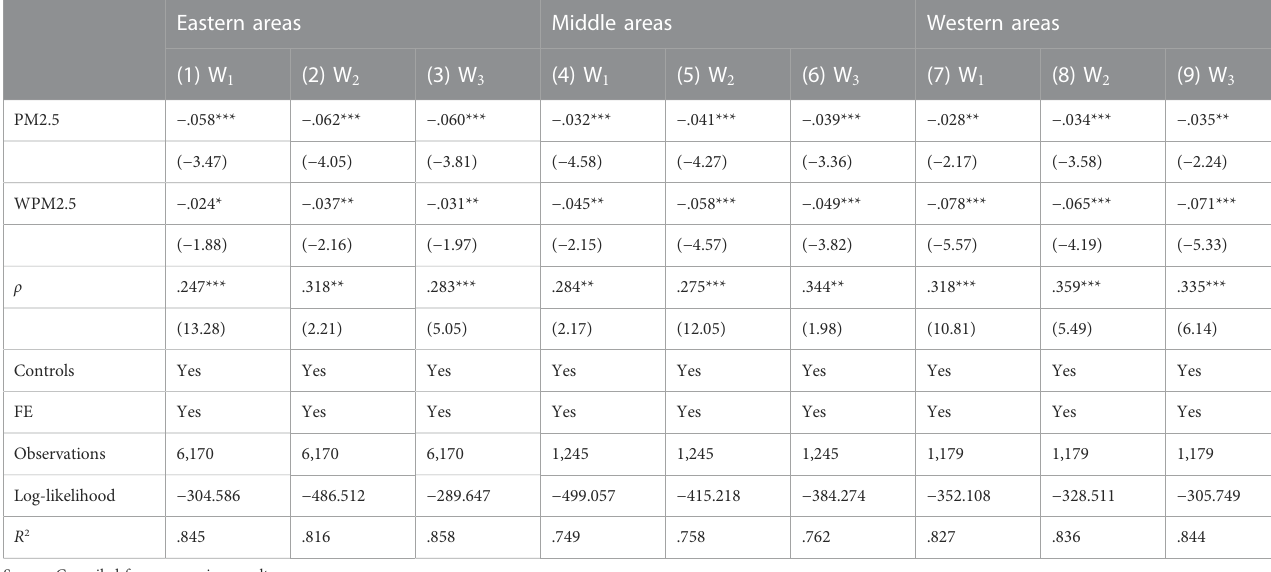
TABLE 6 SDM Regression test: Considering different region and spatial weight matrix. Eastern areas Middle areas Western areas